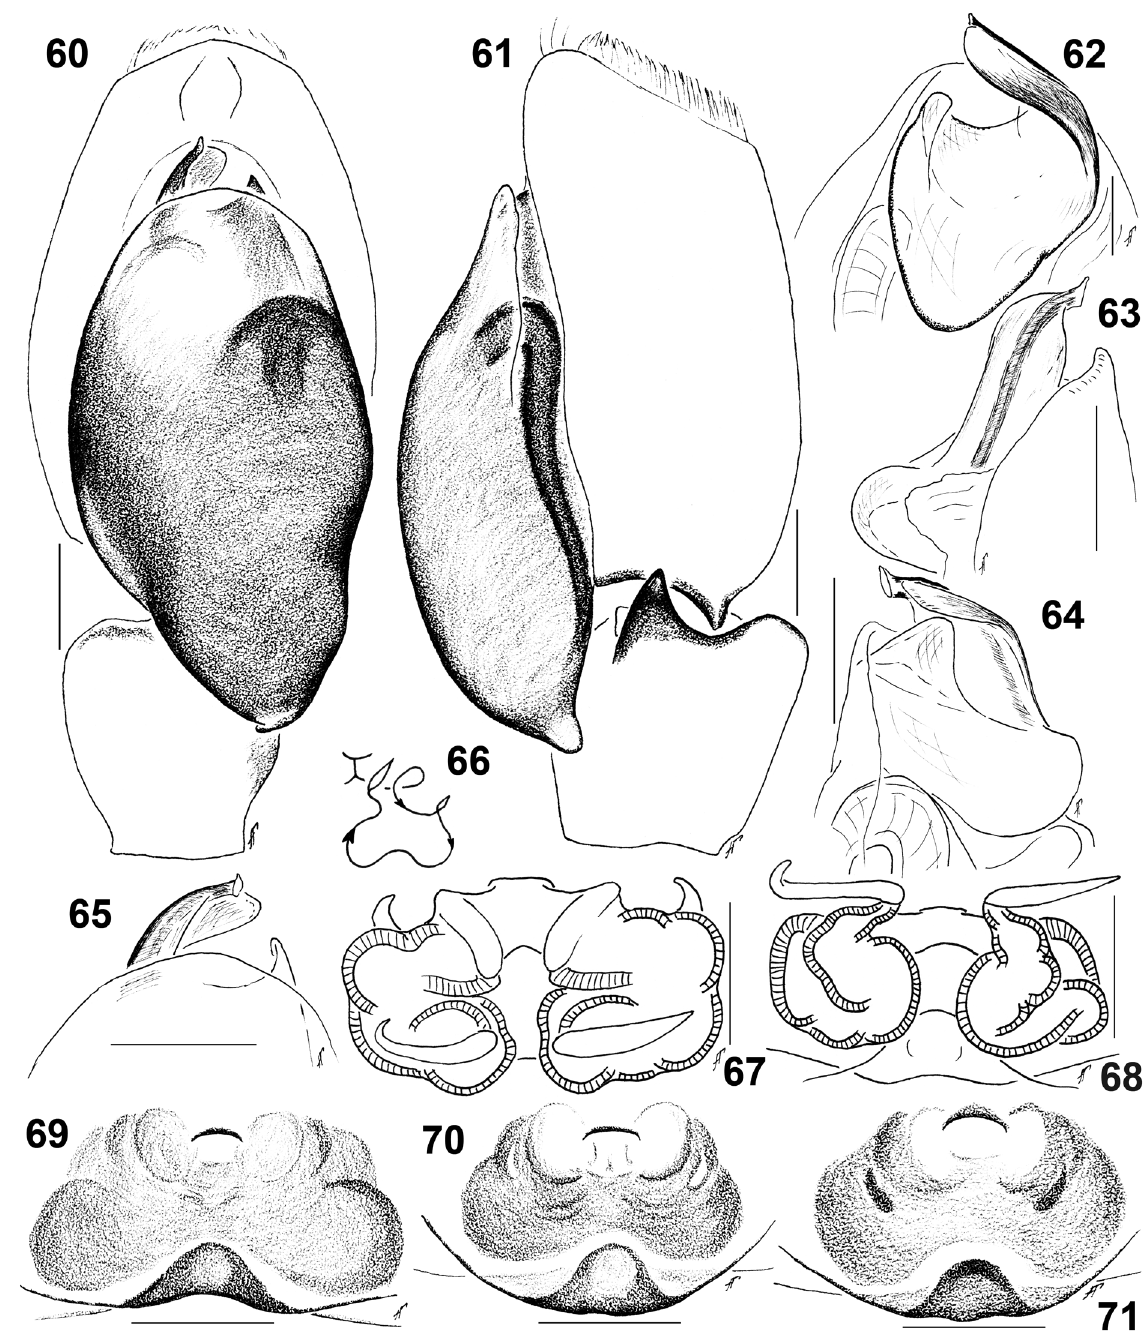
Figs 60–71. Manzuma jocquei (Azarkina, Wesołowska & Russell-Smith, 2011) gen. et comb. nov., ♂♂ from Côte d’Ivoire (Gagnoa, ZMB/Arach 49128, SMF) (60–65), ♀♀ from Côte d’Ivoire (Bouaké, ISEA 001.8352, NCA 2019/730) (67–70) and Central African Republic (Bambari, MRAC 133.906) (71). 60–61 . Male palp. 60 . Ventral view. 61 . Retrolateral view. 62–65 . Embolic division. 62 . Dorsal view. 63 . Prolateral view. 64 . Retrolateral view. 65 . Ventral view. 66 . Diagrammatic course of the insemination ducts. 67–68 . Spermathecae. 67 . Apical view. 68 . Dorsal view. 69–71 . Epigyne, ventral view. Scale bars: 0.1